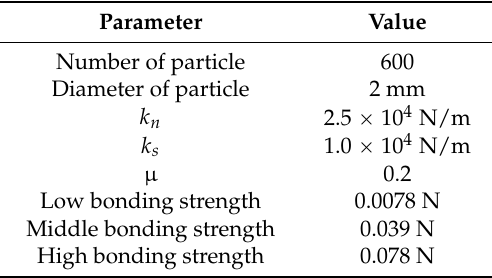
Table 1. The main parameters used in discrete element method